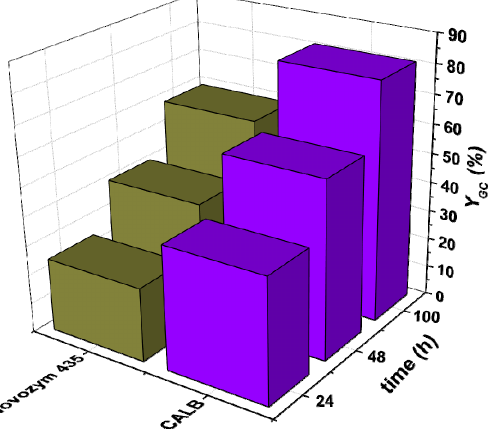
Figure 3. Comparison of the use of the enzymes CALB (lipase B from Candida antarctica ) and Novozyme 435 in the transesterification of glycerol with dimethyl carbonate. Reaction conditions: closed system; T = 60 °C ; DMC:Gly = 3:1; amount of enzyme: 3% w / w ; solvent: tert-butanol (30% v / v ) agitation speed: 400 rpm.